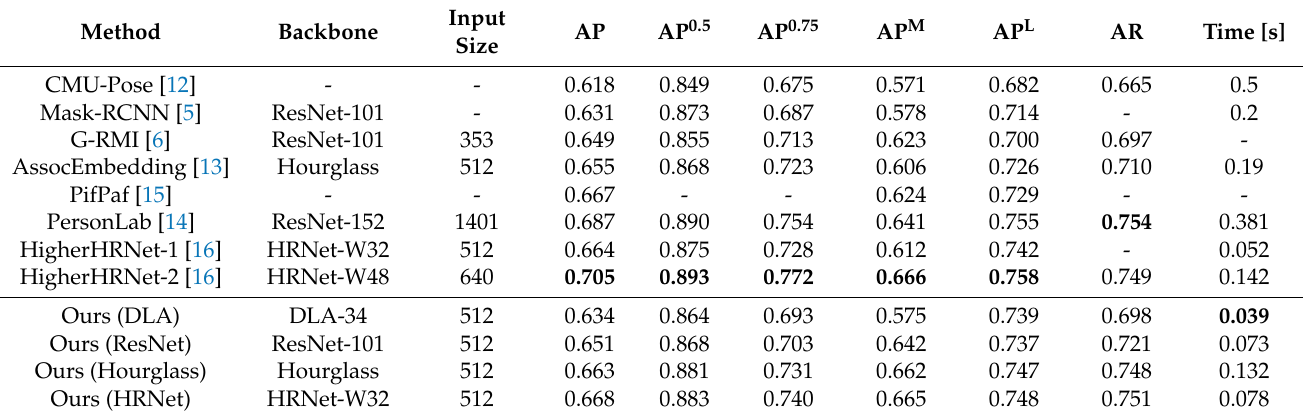
Table 1. Comparisons of our model to other state-of-the-art models on the MSCOCO test-dev daTable 2080. ti GPU. Superscripts M, L of AP stand for medium and large objects. The highest values are indicated in bold.